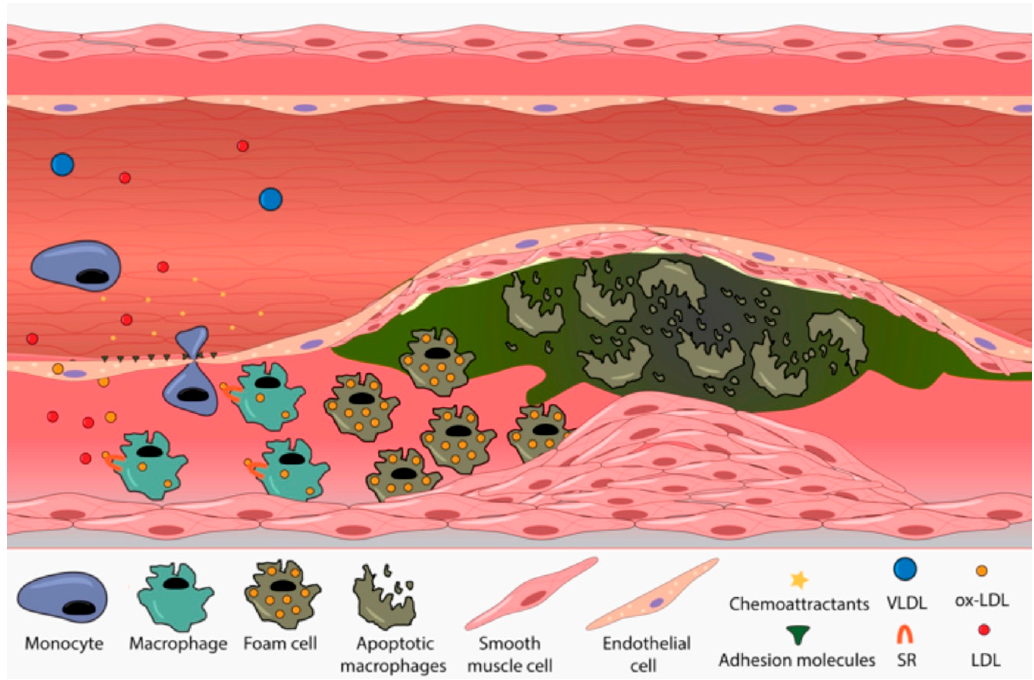
Figure 4. Atherome plaque development. Accumulated LDL particles cross endothelial barrier and get oxidized in subendothelial space. Lipoprotein oxidation activates endothelial cells that increase the synthesis and secretion of chemoattractants and adhesion molecules promoting monocyte recruitment and transedothelial migration. Once at sub-endothelial compartments they are differentiated into machrophages and start to internalize ox-LDL through a non regulated SR-B1 scavenger receptor. Cholesterol excess in macrophages induces foam cell formation and promotes SVMC migration and fibrous cap synthesis. Finally, due to increased macrophage death and impaired efferocytosis, the size of the plaque increases and the diameter of the artery is reduced.